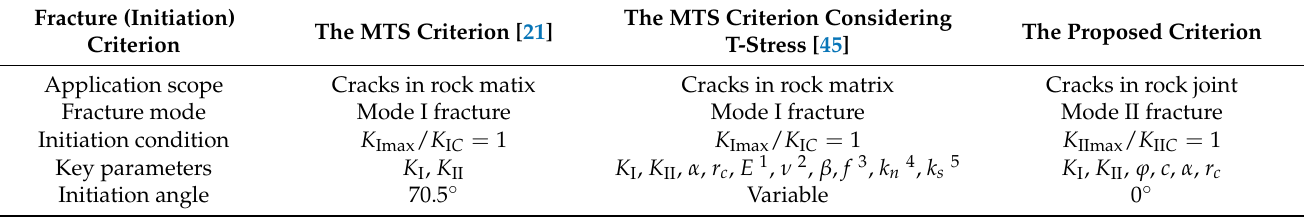
Table 3. Comparison with other traditional